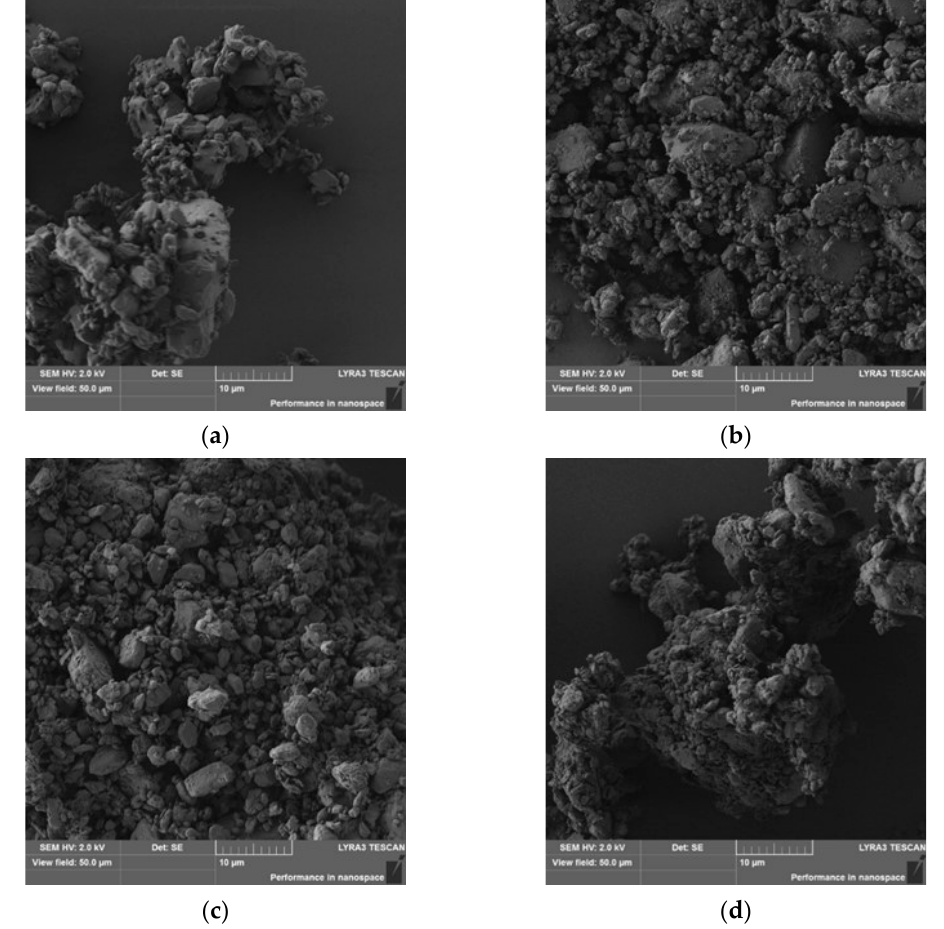
Figure 7. SEM images of the co-milled mixtures of MLX with 10 mm balls for 10 min; ( a ) reference milled sample without SLS (R10-0/10); ( b ) CM10-5/10; ( c ) CM10-15/10; ( d ) CM10-25/10.